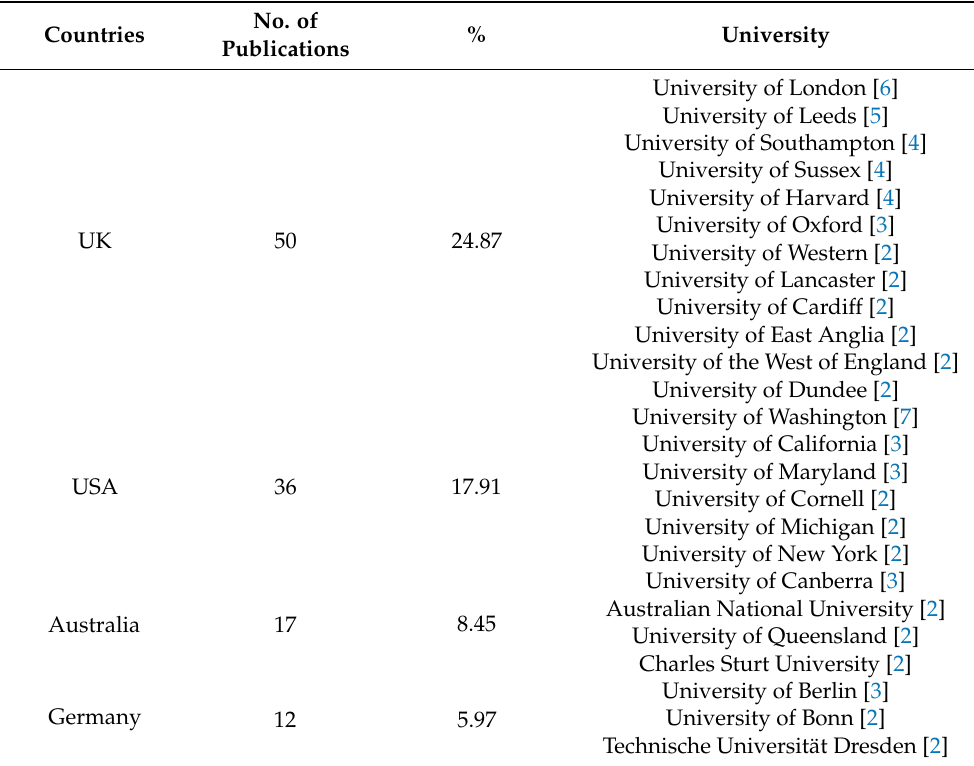
Table 3. Publications by country and